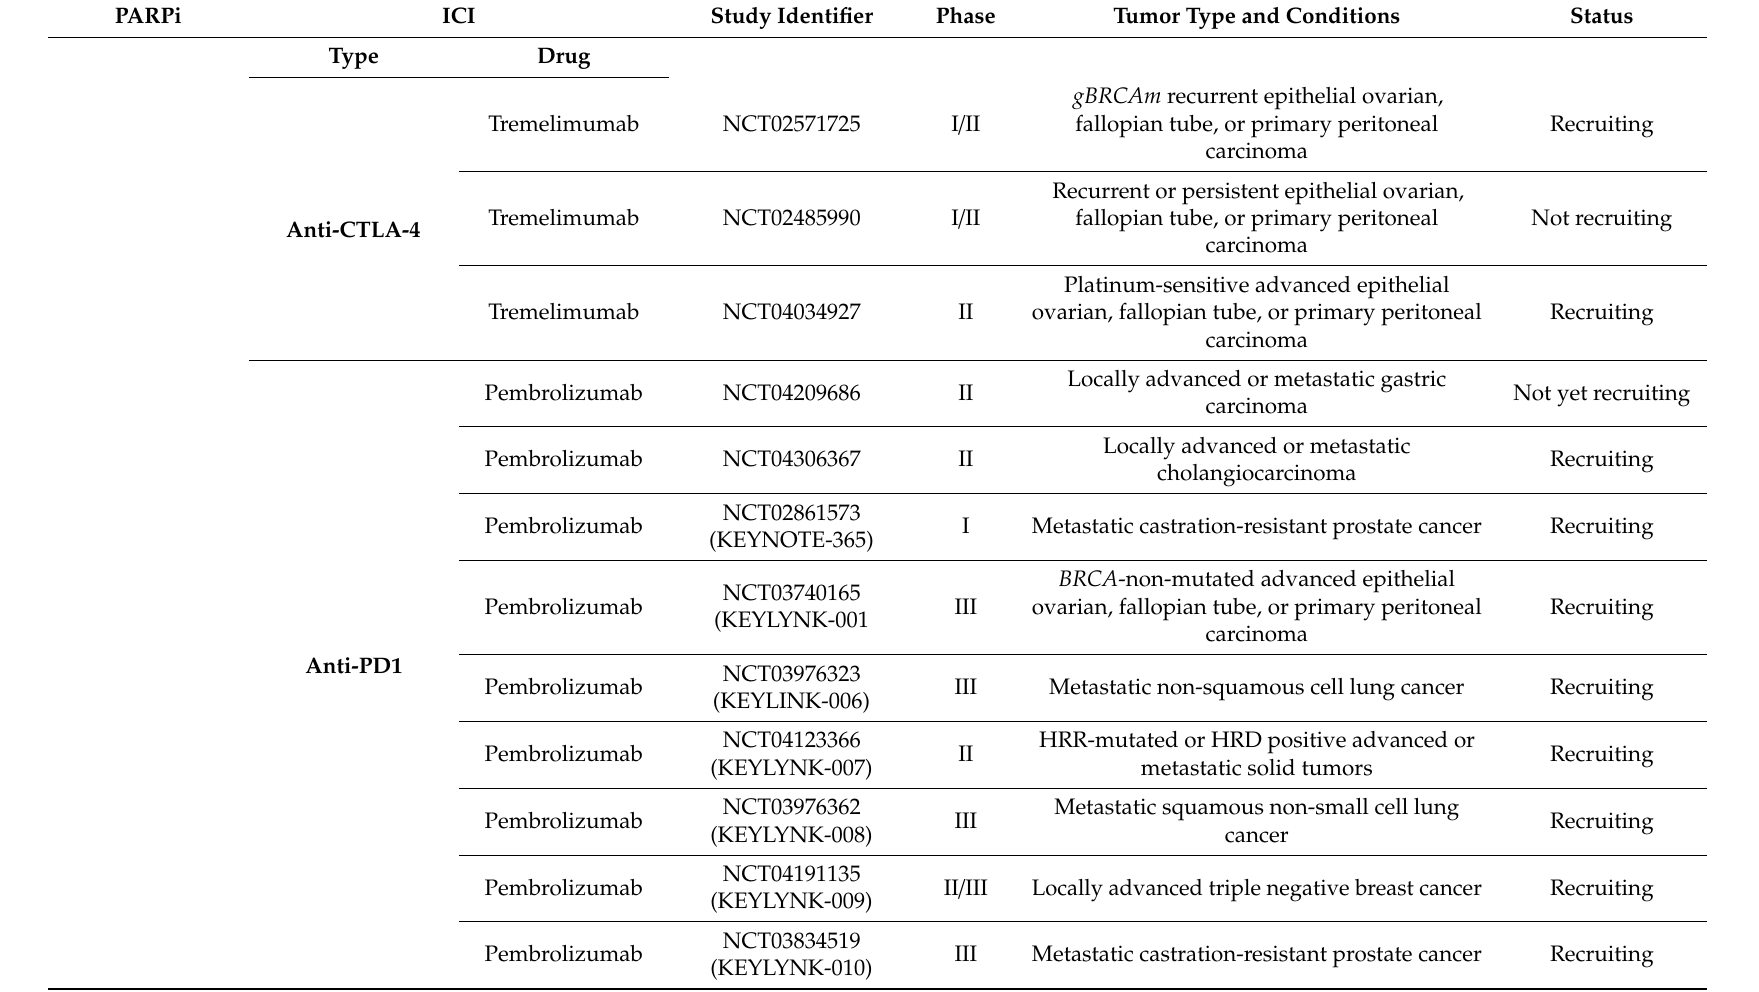
Table 2. Ongoing clinical trials of combination of PARPi and ICIs